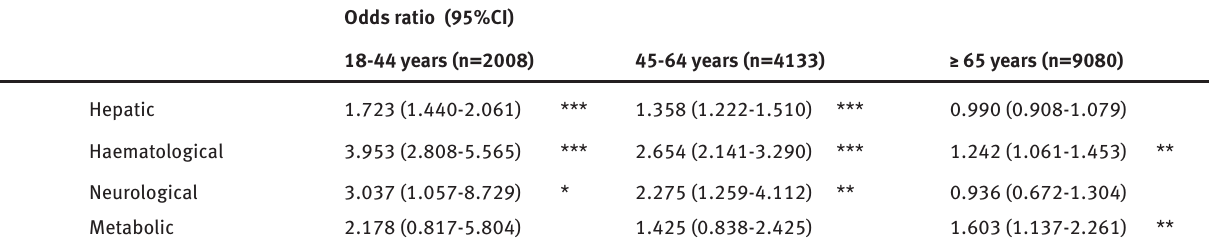
Abbreviation: CI, confidence interval, COPD, chronic obstructive pulmonary disease. * *, **, *** Statistically significant, respectively P <0.05, P <0.01, P <0.0001.